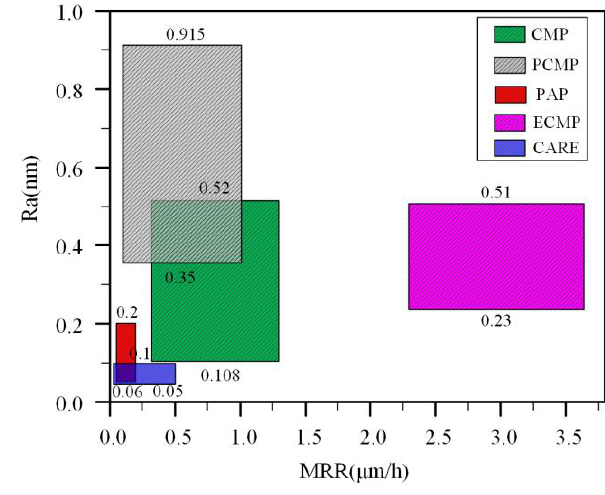
Figure 32. Ra vs. MRR of different polishing techniques.